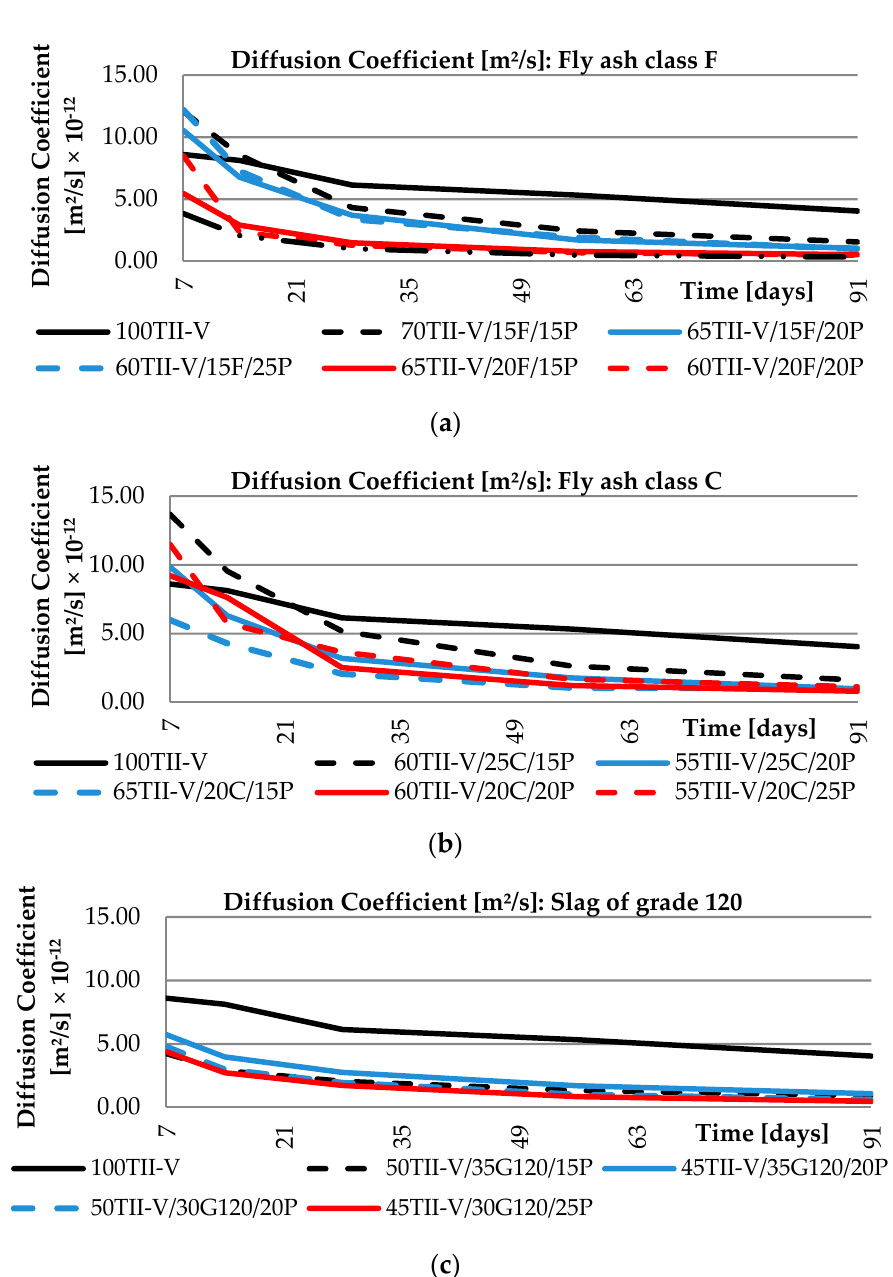
Figure 6. Time-dependent variation of diffusion coefficient: ( a ) fly ash class F group; ( b ) fly ash class C group; ( c ) slag of grade 120 group.